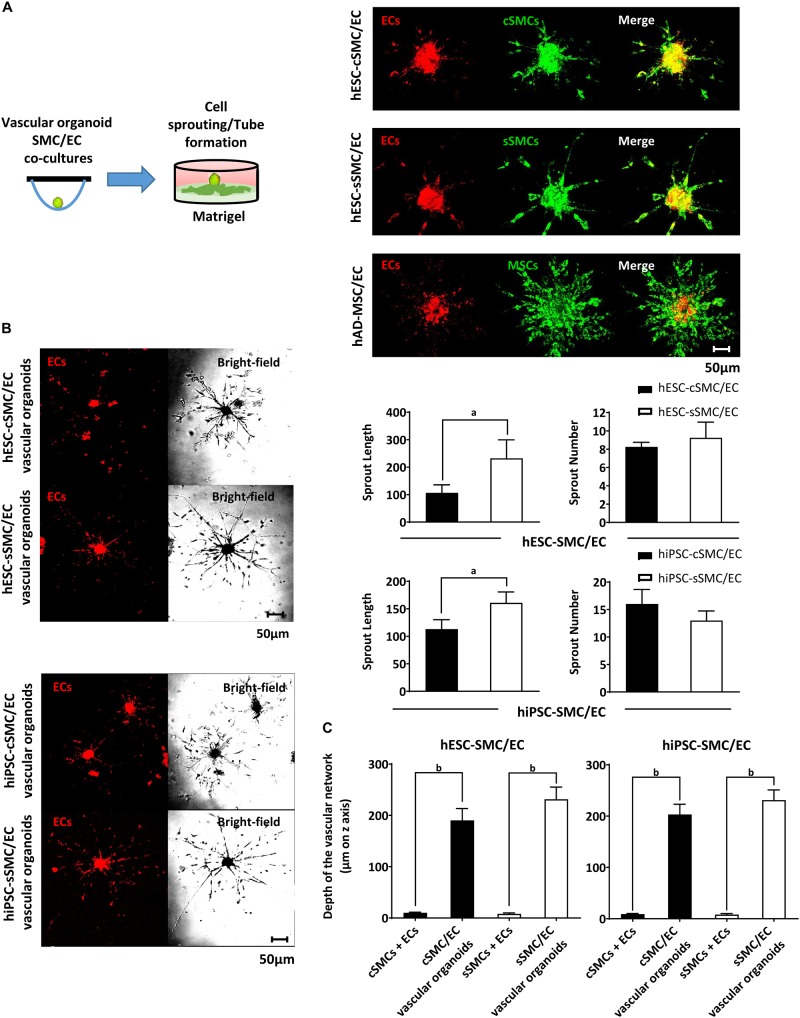
Functional characterization of vascular organoids in vitro.
(A) hPSC-SMC subtype/EC vascular organoids generated using the hanging drop method, were added on matrigel and allowed to develop sprouts (illustration). Representative images of hESC-cSMC/EC, hESC-sSMC/EC vascular organoids and hAD-MSC/EC spheroids 3d after their addition to matrigel. Red immunofluorescence indicates ECs (prelabeled with PKH26, left column), green fluorescence indicates hESC-cSMCs, hESC-sSMCs, and hAD-MSCs (pre-labeled with PKH67, middle column) and the merge is shown in the right column. Images were taken on Leica TCS SP5 confocal microscope and are representative of at least three independent experiments. Scale bar, 50 μm. (B) Representative images of (hESC-cSMC/EC, hESC-sSMC/EC vascular organoids (upper panel) and hiPSC-cSMC/EC, hiPSC-sSMC/EC vascular organoids (lower panel) 3d after their addition on matrigel. Red immunofluorescence indicates ECs (prelabeled with PKH26, left column), whereas phase-contrast images of the same microscopic field are shown on the right column. Images were taken on Leica TCS SP5 confocal microscope and are representative of at least three independent experiments. Scale bar, 50 μm. Charts presenting length of sprouts (left) and number of sprouts (right) from hESC-cSMC/EC, hESC-sSMC/EC vascular organoids (upper charts) and hiPSC-cSMC/EC, hiPSC-sSMC/EC vascular organoids (lower charts). Images were taken 3d after the vascular organoids were plated on matrigel. Number and length of the sprouts were quantified using imageJ software and they are expressed as means ± SD from three independent experiments. aP < 0.05. (C) Charts presenting the depth of the vascular network from hESC-cSMCs + ECs, hESC-sSMCs + ECs single cells or equal number of cells organized as vascular organoids (left chart) and hiPSC-cSMCs/ECs, hiPSC-sSMCs/ECs single cells or equal number of cells organized as vascular organoids (right chart). Images were taken 3d after single cells or vascular organoids had been plated on matrigel. Distance of vascular network invasion in the matrigel was quantified on Leica TCS SP5 confocal microscope (z axis) and it is expressed as mean ± SD from three independent experiments. bP < 0.01.)